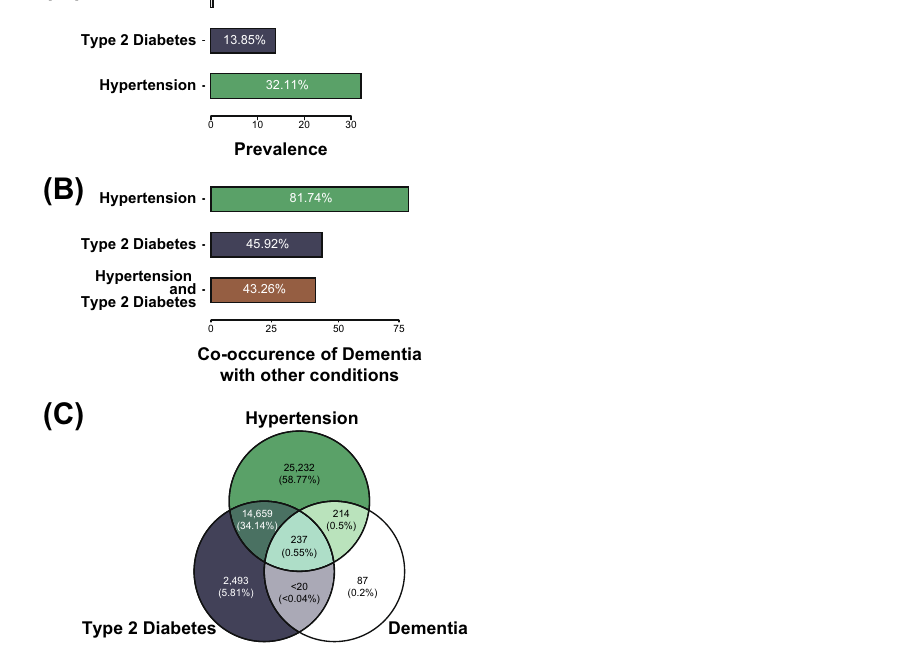
Figure 3. Prevalence for dementia along with hypertension and T2D comorbidities in the AoU participant cohort. ( A ) Prevalence of the three conditions under consideration: dementia, T2D, and hypertension. ( B ) Co-occurrence of dementia with hypertension and T2D. Each bar represents the percentage of participants with dementia who also have one or both of the comorbidities under investigation. ( C ) Venn diagram for the three conditions being studied. Values under the reporting minimum are represented as ‘<